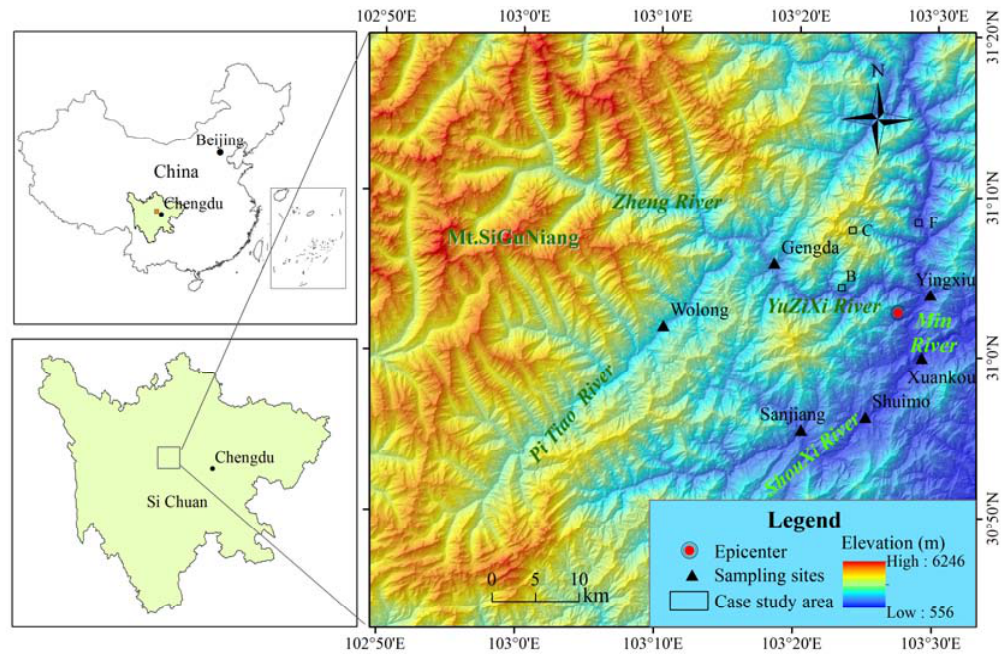
Figure 1. Location map of the study area Yingxiu near the epicenter of the Wenchuan earthquake on 12 May 2008, and topographic features of a digital elevation model with 25 m resolution from the national topographic database of China. For the case study area, F denotes farmland, C denotes coniferous forest, and B denotes broadleaved forest.